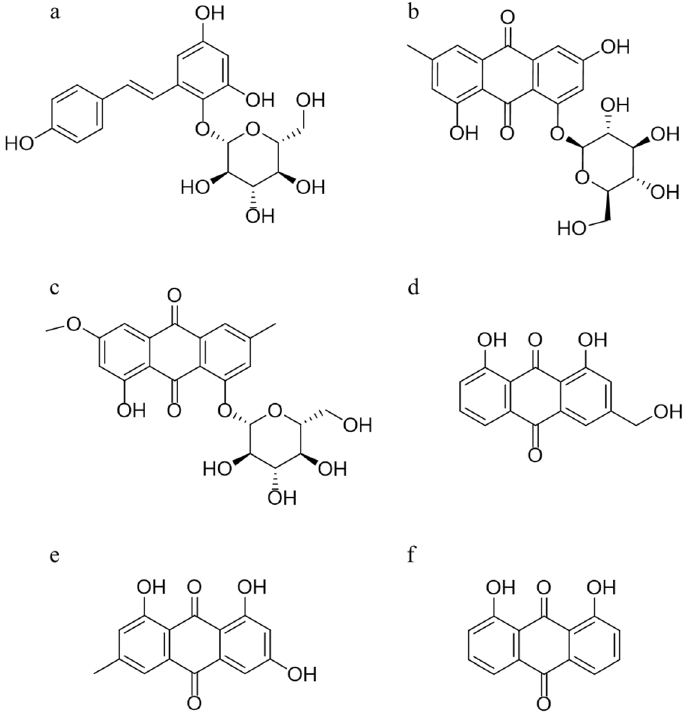
Figure 1. Chemical structures of TSG ( a ), EG ( b ), PG ( c ), AE ( d ), EM ( e ), and the internal standard 1,8-dihydroxyanthraquinone ( f ).